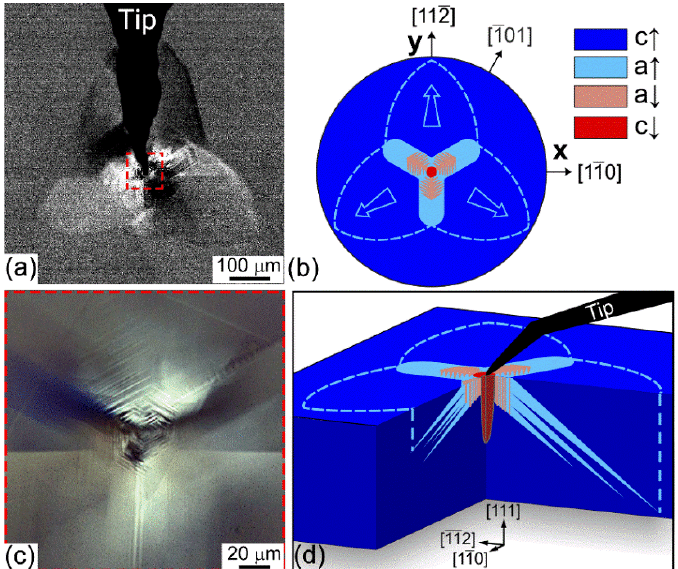
Figure 2. ( а ) Optical image of the domain structure obtained during the application of 96 V to the